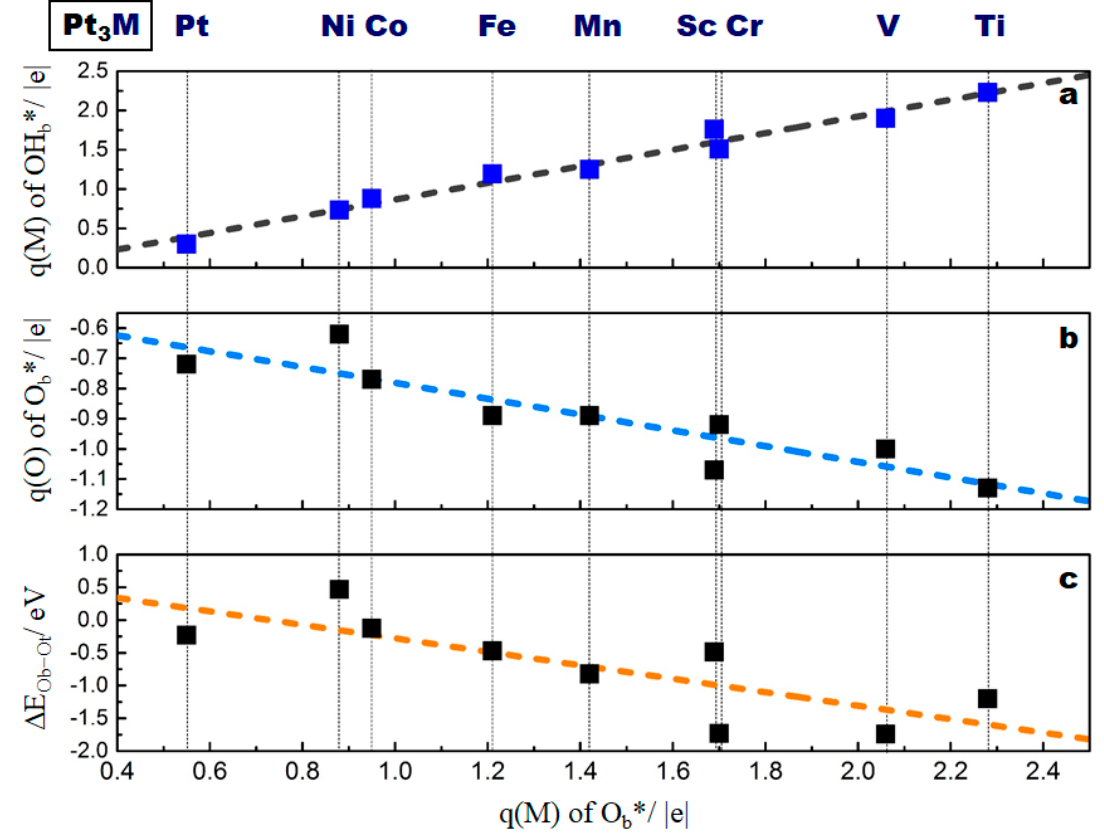
Figure 4. The Bader charges on the ( a ) OH* intermediate, ( b ) O b * adatoms, and ( c ) the adsorption energy difference between O b * and O t * as a function of the charge changes of interfacial M sites. The vertical dash line indicates the location of the Bader charge values of the corresponding element.